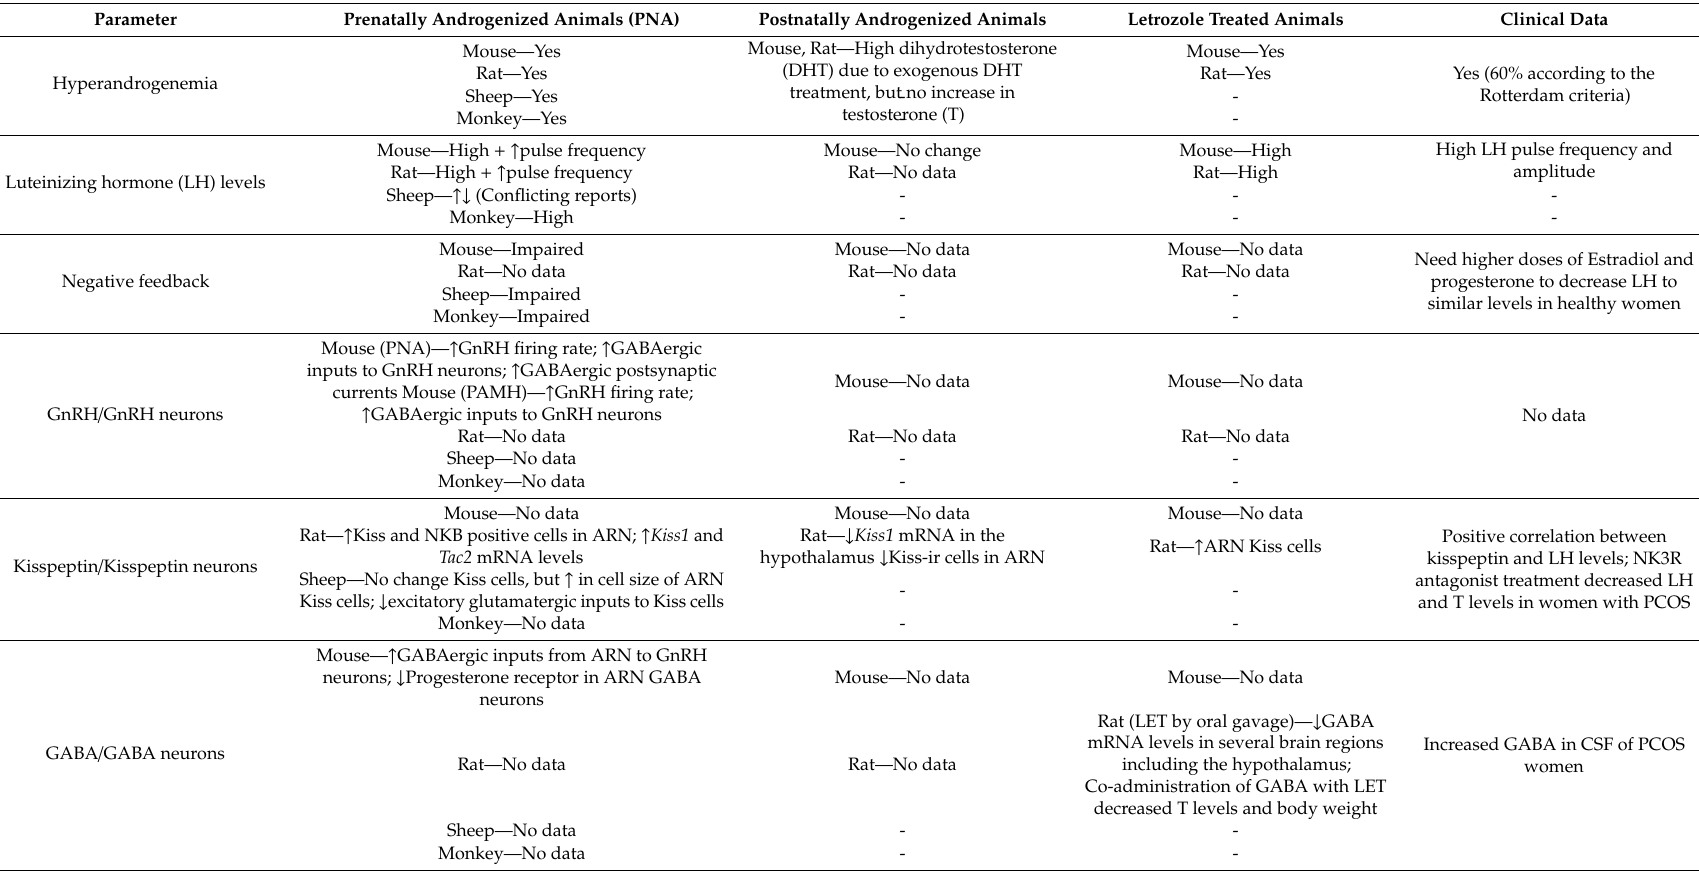
Table 1. Characteristics of polycystic ovary syndrome (PCOS) and alterations in the neuroendocrine axis in preclinical PCOS animal